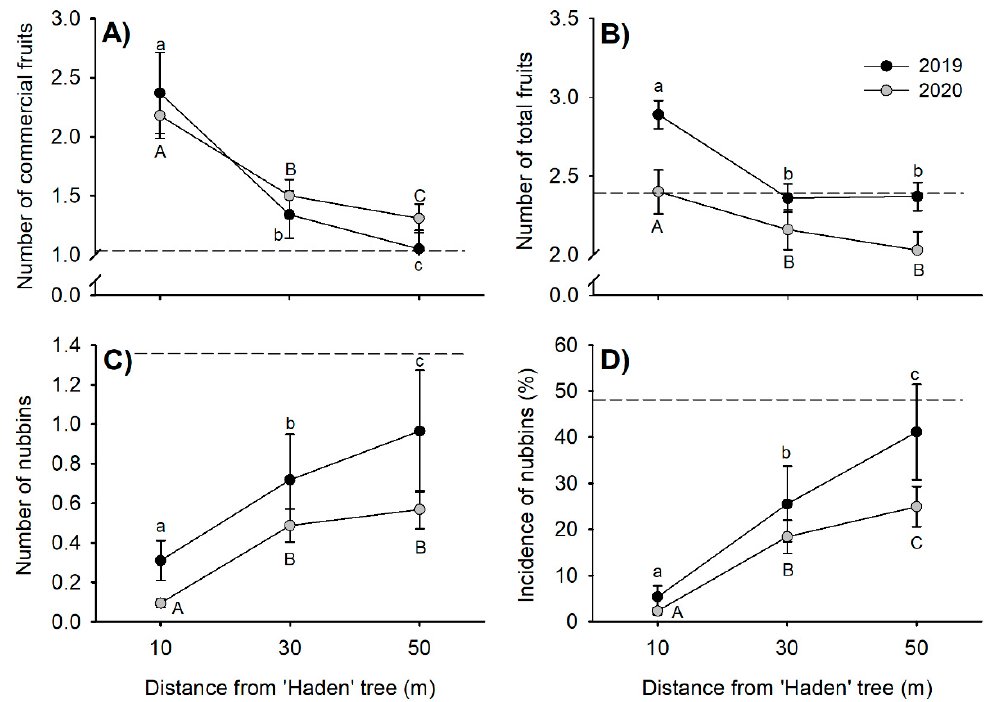
Figure 2. Mango production per panicle of ‘Ataulfo’ trees (mean ± standard error) located at different distances from trees of ‘Haden’ in 21 orchards (9 in 2019, n = 360 panicles per distance; 12 in 2020, n = 420) from the Costa Grande, Guerrero, Mexico. ( A ) Number of commercial fruits, ( B ) Number of total fruits, ( C ) Number of nubbins; and ( D ) Incidence of nubbins. Dotted lines indicate the average values of ‘Ataulfo’ trees in orchards without ‘Haden’ individuals. Different letters indicate statistical differences among distances for each sampling period according to GLMM and Tukey test ( p < 0.05).